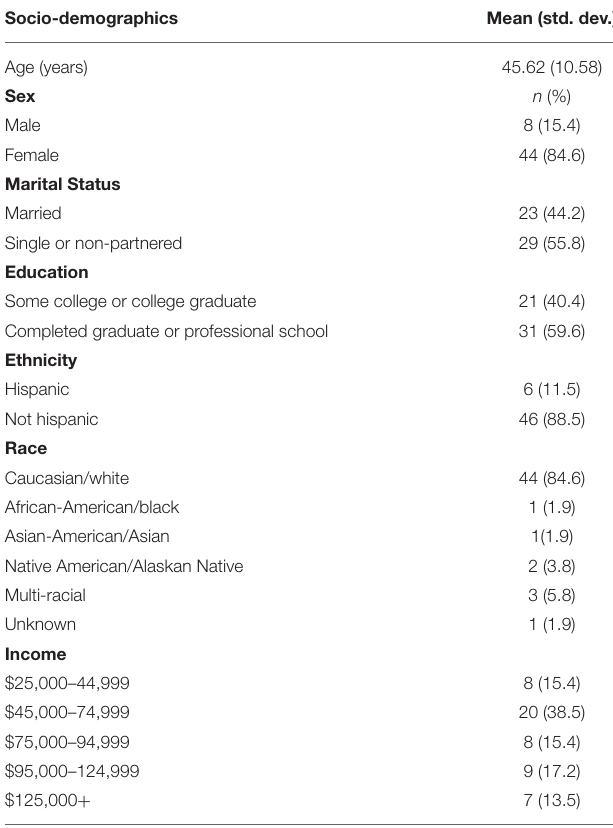
TABLE 1 | Sociodemographic characteristics of participants at baseline ( n = 52). Socio-demographics Mean (std.